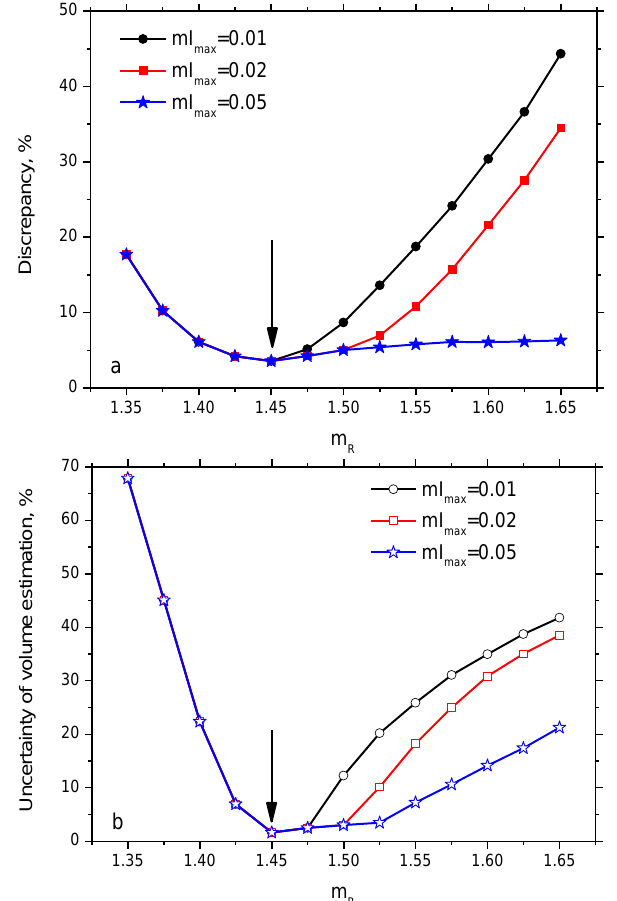
Fig. 1. (a) Discrepancy and (b) uncertainty of volume estimation as a function of assumed values of the real part of the refractive index for different ranges of considered values of the imaginary part with maximum values m I = 0 . 01, 0.02, 0.05. The simulation was performed for a log-normal PSD with modal radius r 0 = 0 . 15µm and dispersion ln σ = 0 . 4. The arrow shows the real part of the refractive index m R = 1 . 45 for the synthetic data.